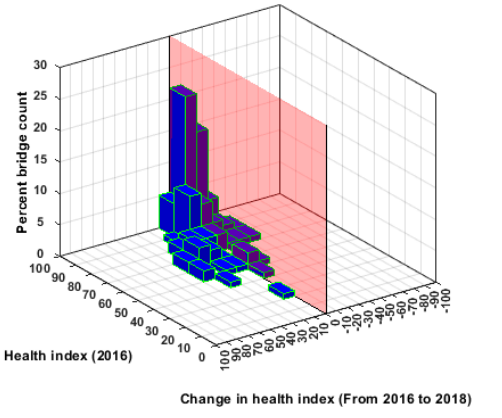
Figure 15. National Highway System (NHS) vs. non-NHS bridge in New York.